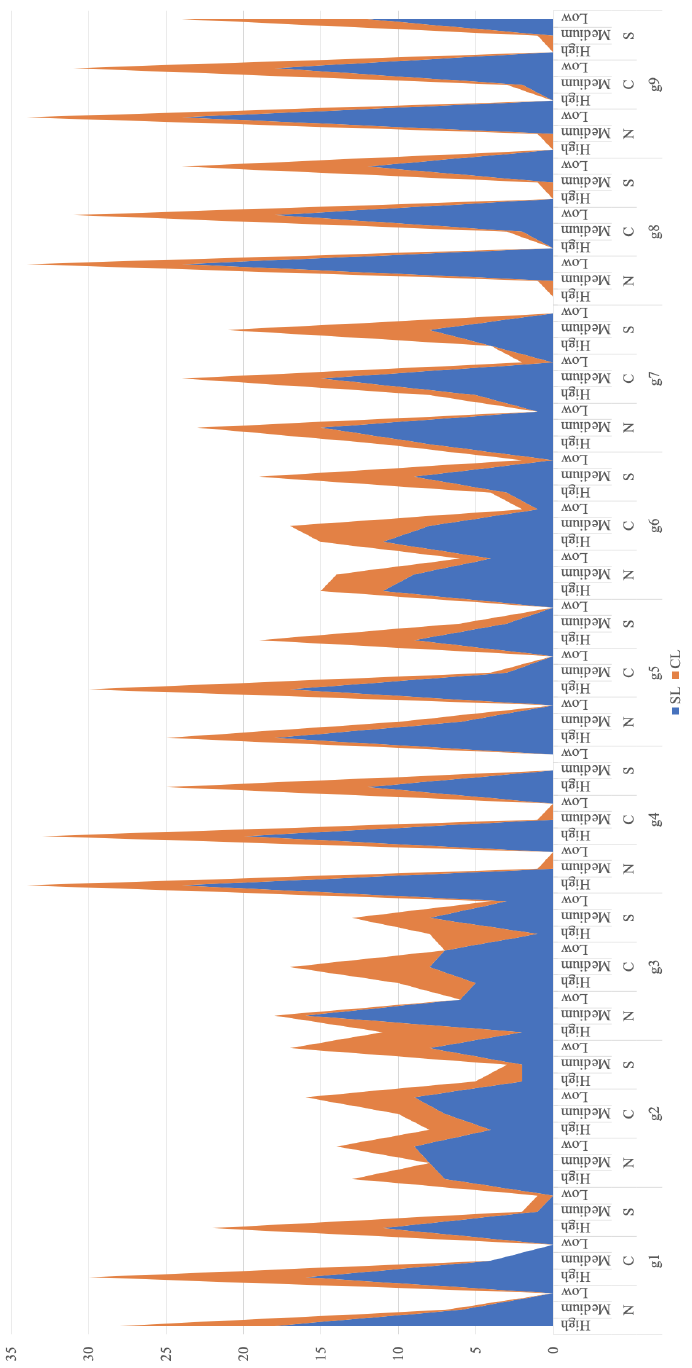
Figure 4: Performance of SLs and CLs sorted for criteria and geographical areas